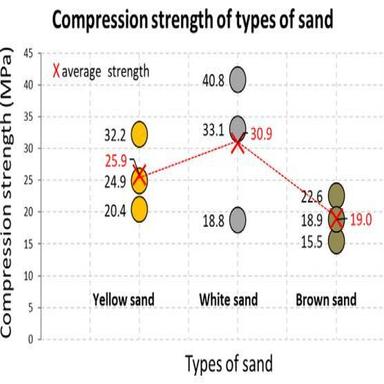
Compression strength for the three types of sand.